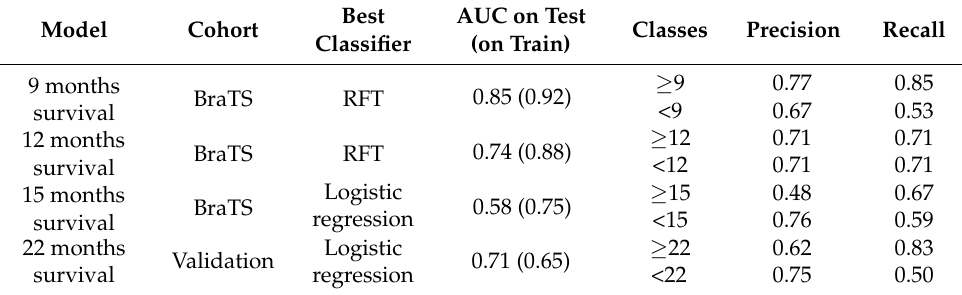
Table 4. Results metrics of the classification models on the test